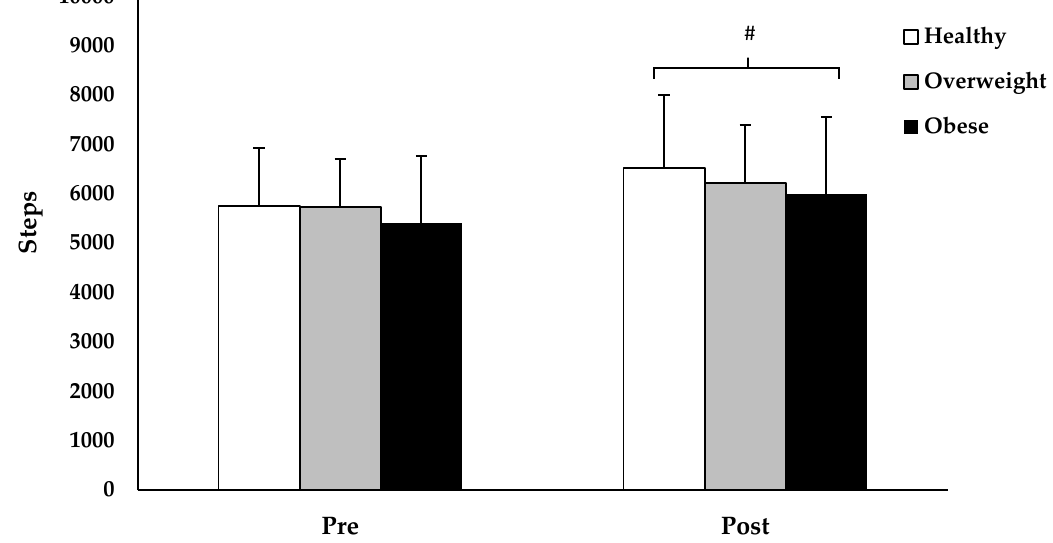
Figure 3. Changes in step count across BMI status, following 4 weeks of the TAKE 10! ® curriculum intervention. Values are presented as mean ± SD. # Greater compared to pre-intervention ( p < 0.001).